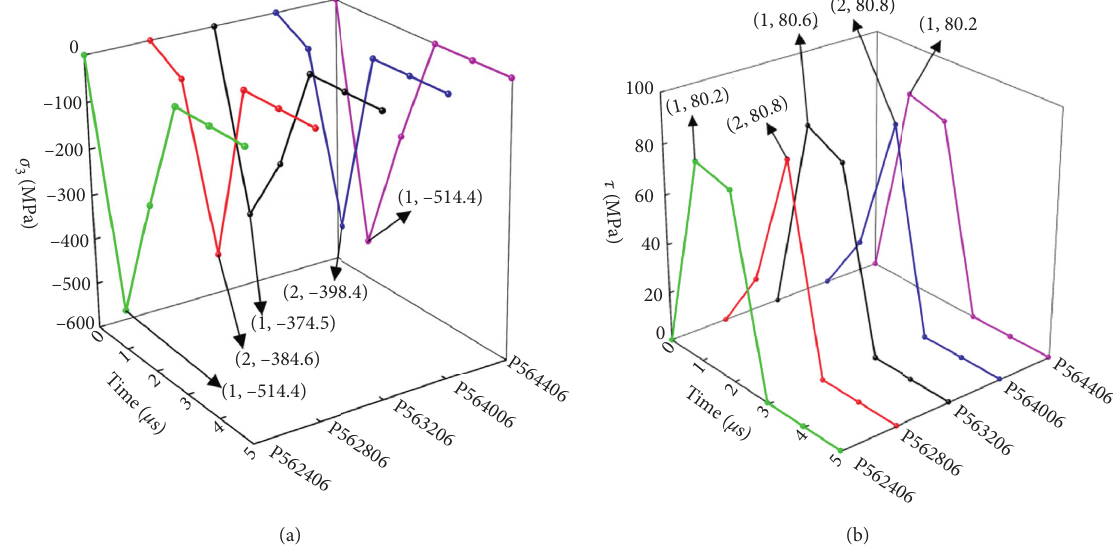
Figure 3: Stress curves of typical particles in the solid-liquid contact area: (a) compressive stress; (b) shear stress.